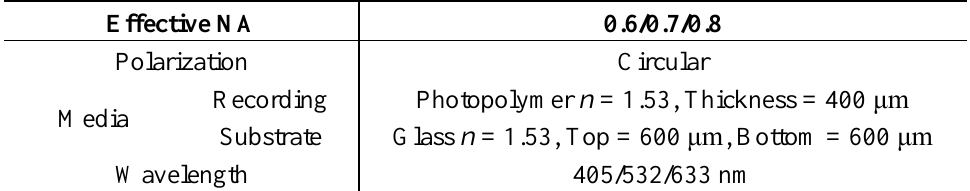
Table 1. Optical parameters for numerical simulation model.